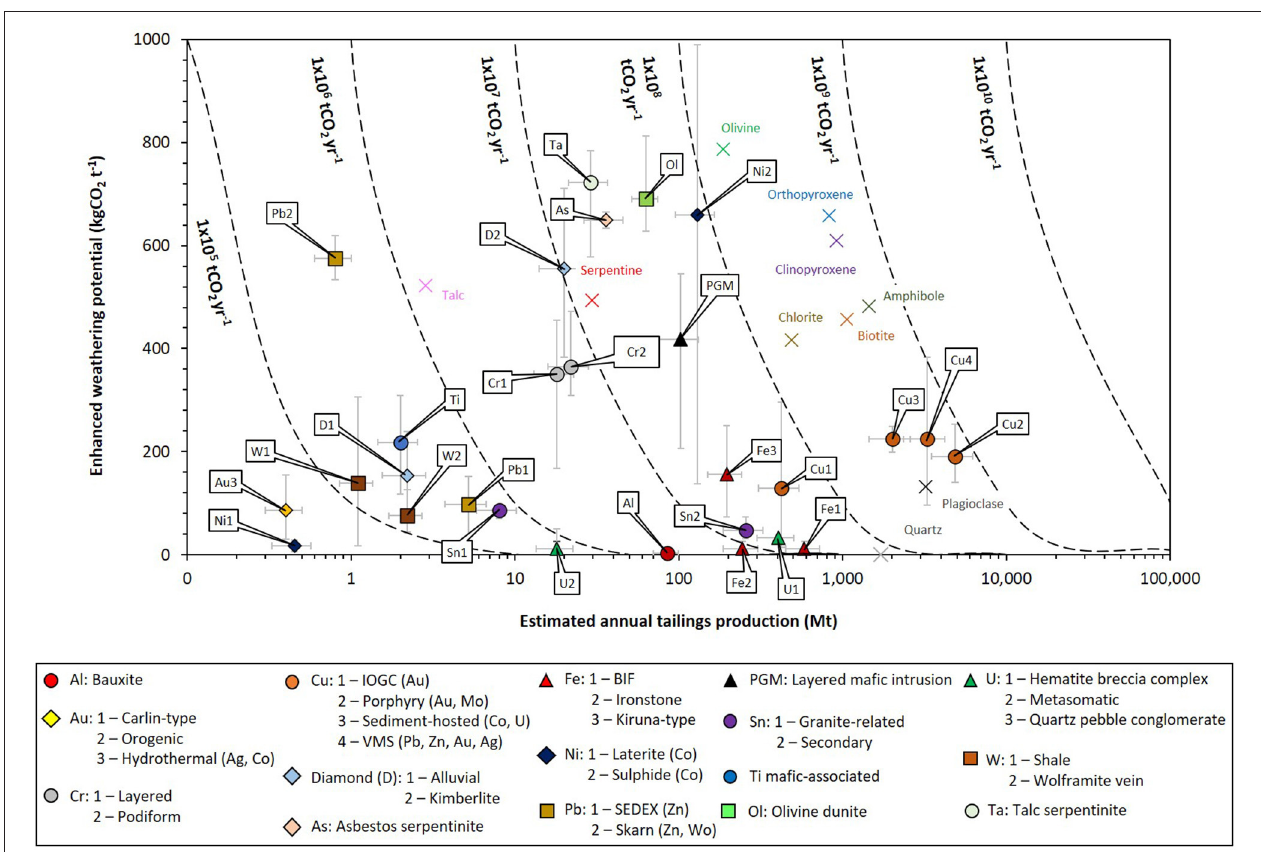
FIGURE 3 | Calculated E pot values (with error bars accommodating variations in geochemical composition) vs. estimated mean ATP X (error bars based on variations in economic cut-off grades) for commodity-hosting silicate deposit types. Contours show CO 2 -capture in tCO 2 year − 1 . Typical gangue minerals also shown (based on estimated abundances in deposit